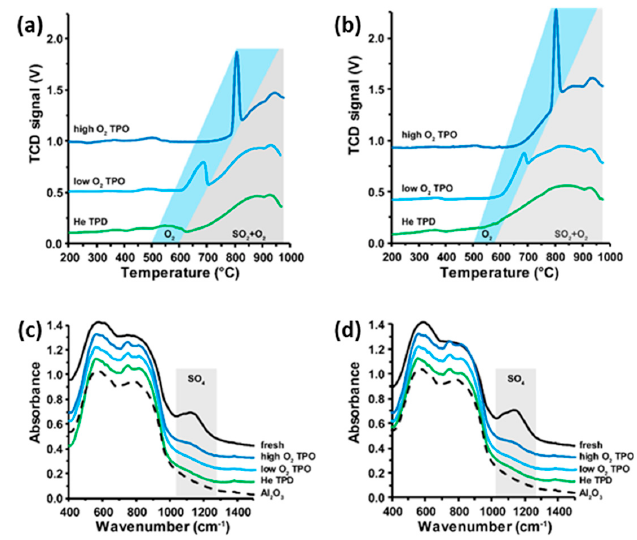
Figure 8. Thermal decomposition curves of ( a ) 0.25 AS + PS/Al 2 O 3 and ( b ) 1.0 AS + PS/Al 2 O 3 model catalysts and ( c ) FTIR spectra of 0.25 AS + PS/Al 2 O 3 and ( d ) 1.0 AS + PS/Al 2 O 3 model catalysts before and after decomposition, accompanied by a reference spectrum of Al 2 O 3 .